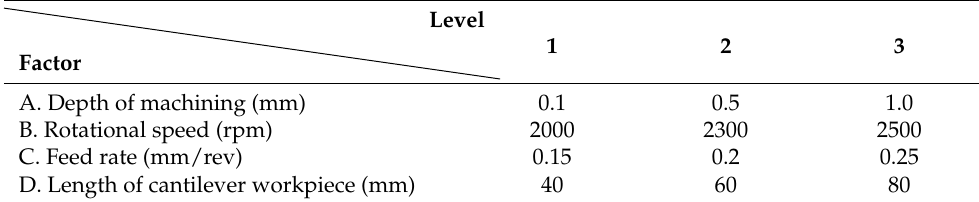
Table 1. Factor and standard.